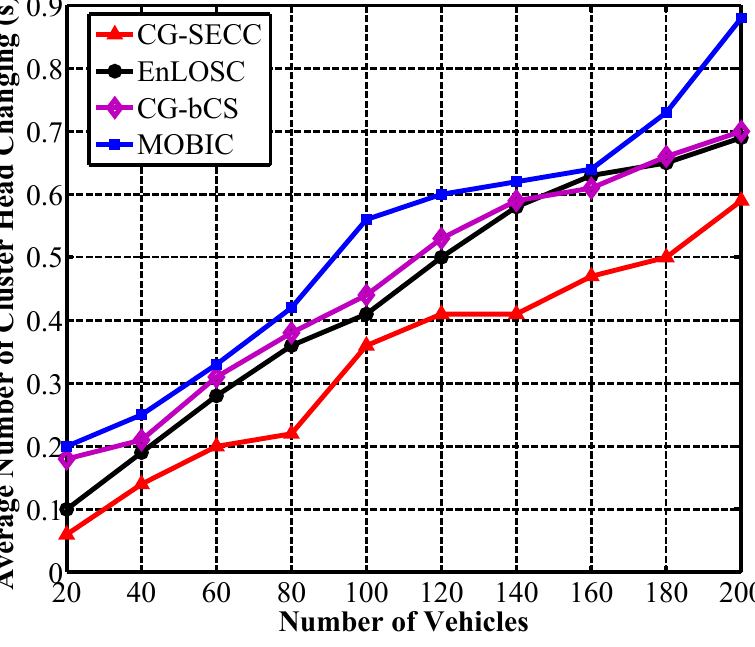
Figure 5. Analysis of cluster